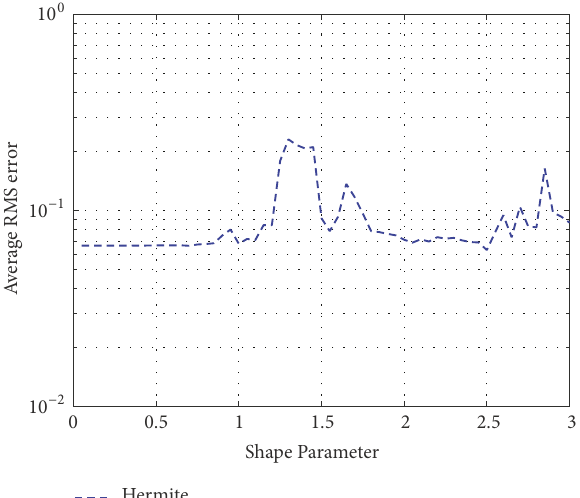
Figure 8: Average 𝐿 𝑟𝑚𝑠 - error obtained from using Hermite collocation scheme at Re = 1,000 with 𝑡 = 0.5,Δ𝑡 = 0.005 , and 𝑁 = 10 × 10